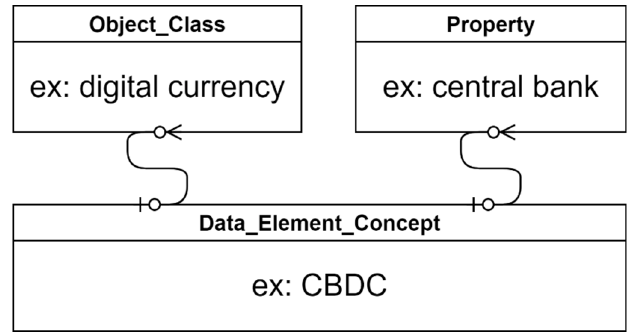
Figure 2. Data Element Structure of MDR.